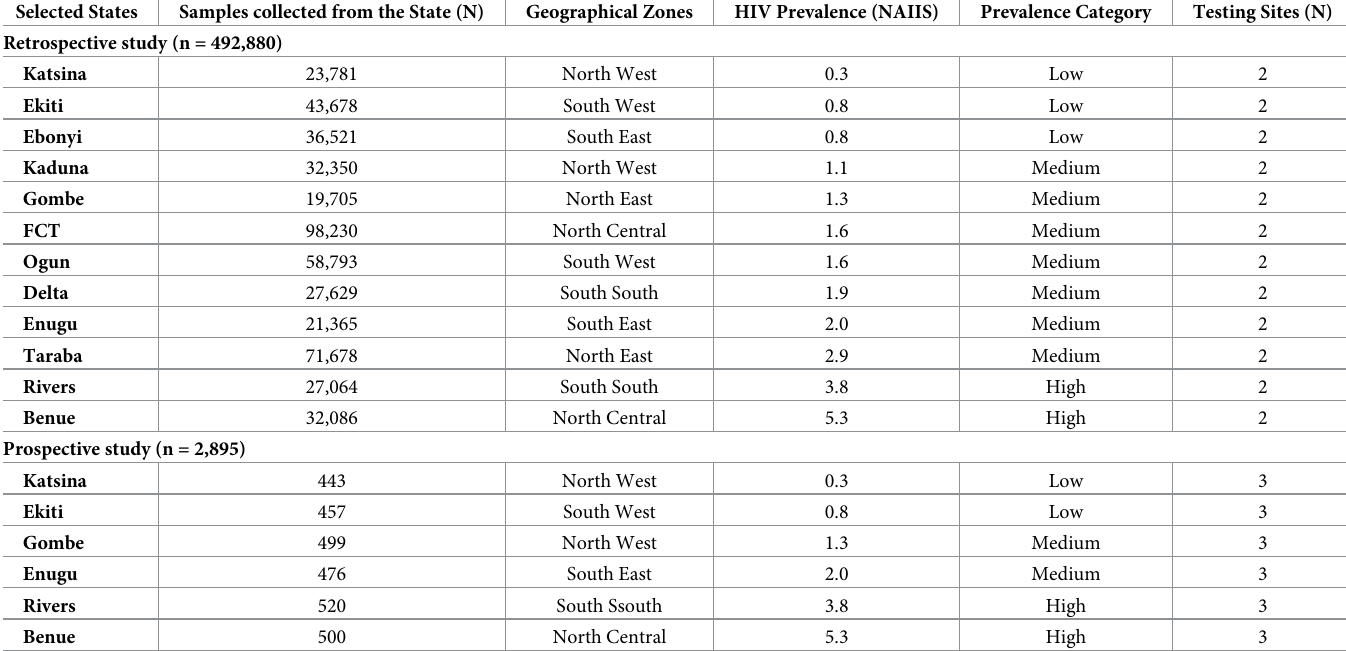
Table 1. The number of samples collected by States, geographical zones, HIV prevalence, and testing sites. Selected States Samples collected from the State (N)